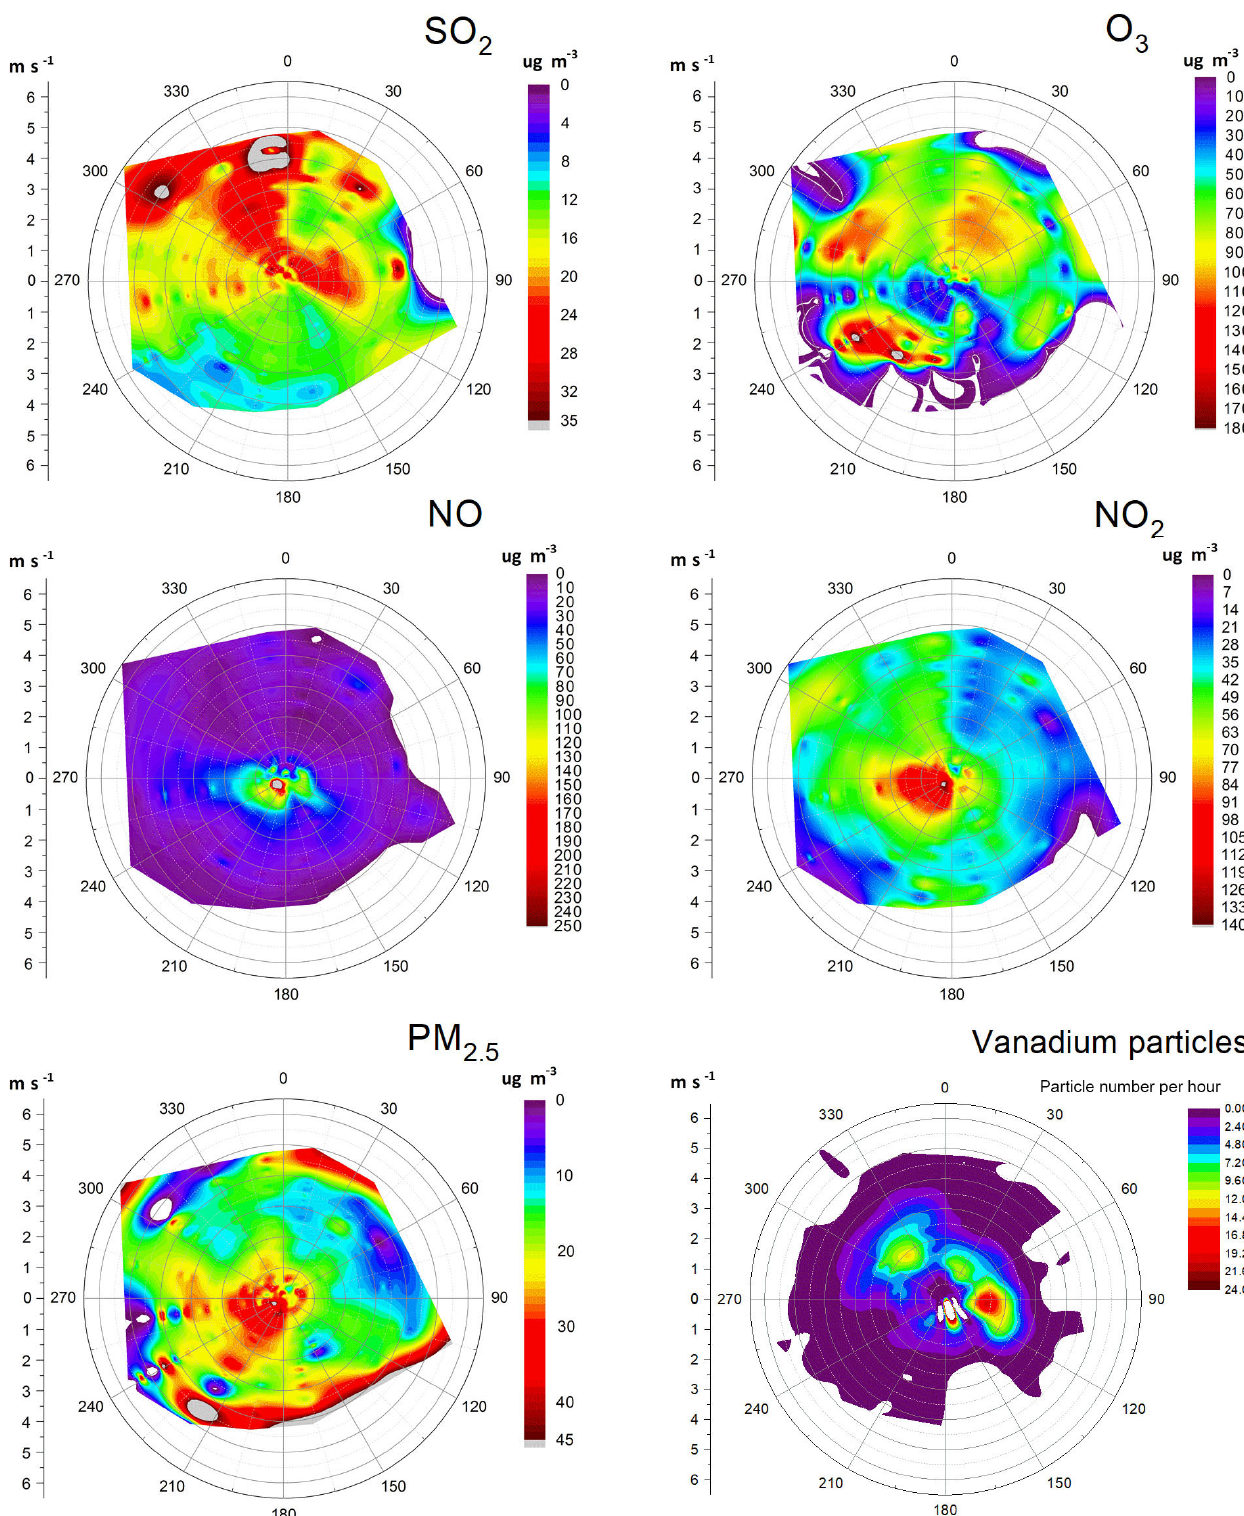
Figure 8. Pollution wind roses of SO 2 , NO, NO 2 , O 3 , PM 2 . 5 and vanadium particles during the whole study period. The vanadium particle wind rose is based on the number concentration as measured by the SPAMS